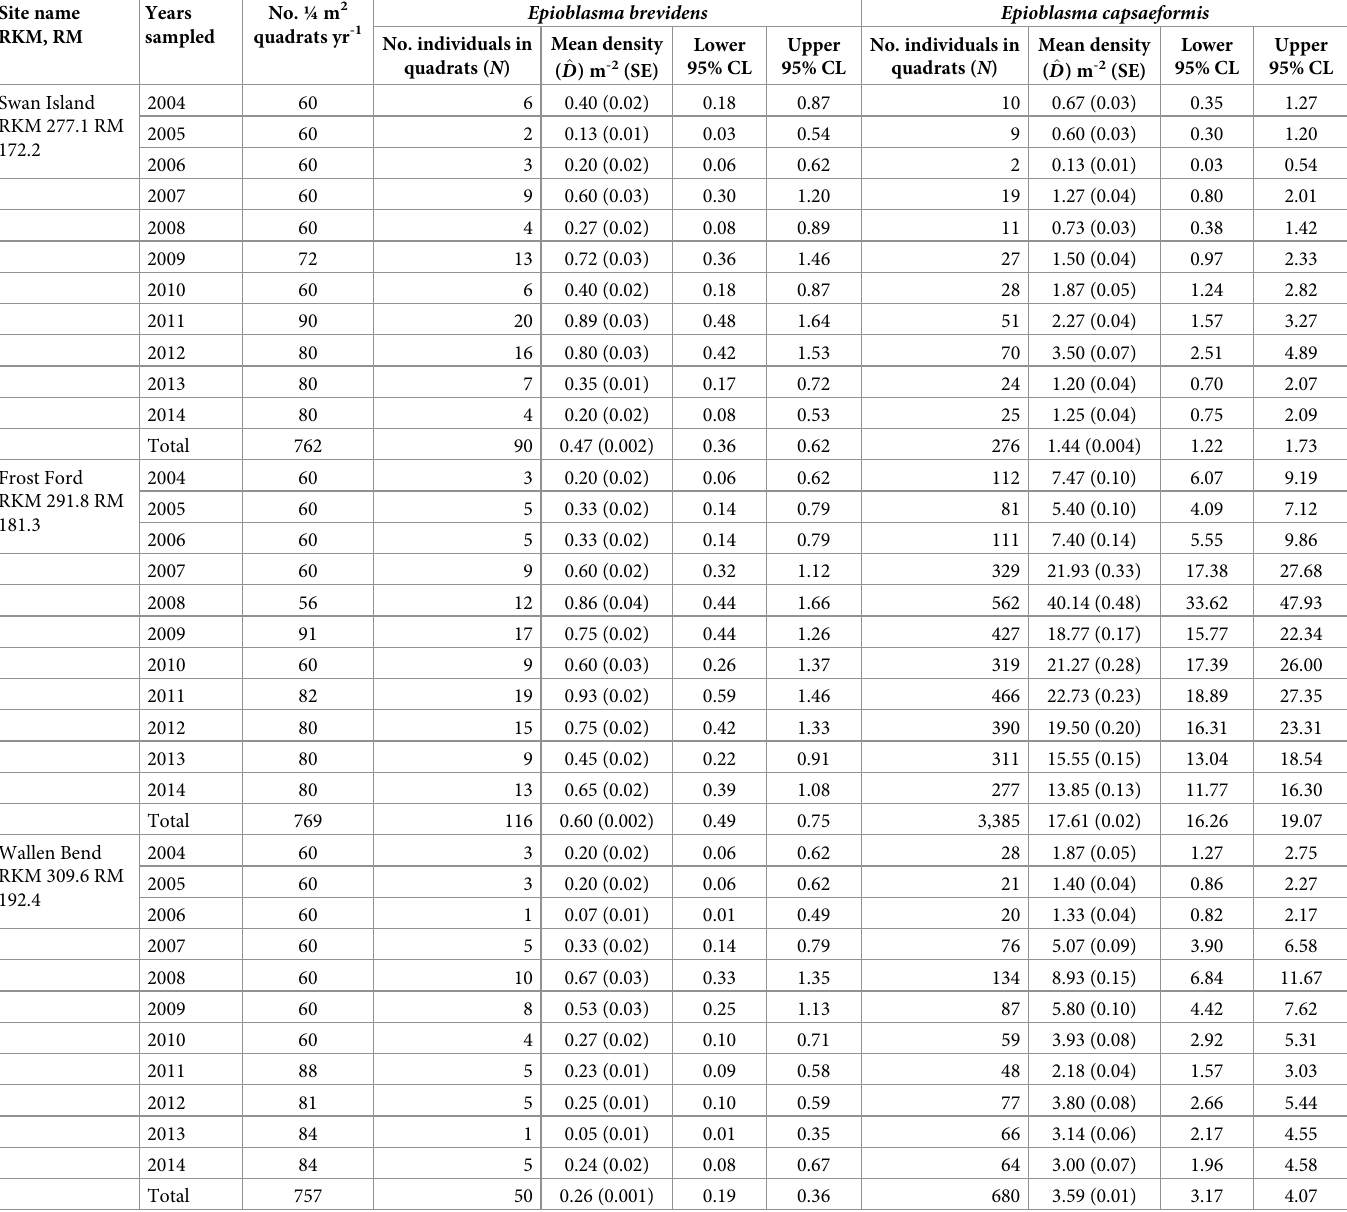
Table 1. River kilometer (RKM) and river mile (RM) for each site censused from 2004–2014 in the Clinch River, TN. The total number of ¼ m 2 quadrats excavated and raw number of individuals encountered in quadrats were used to estimate mean densities (mussels/m 2 ) and 95% confidence limits (CL) for Epioblasma brevidens and E . capsaeformis by census